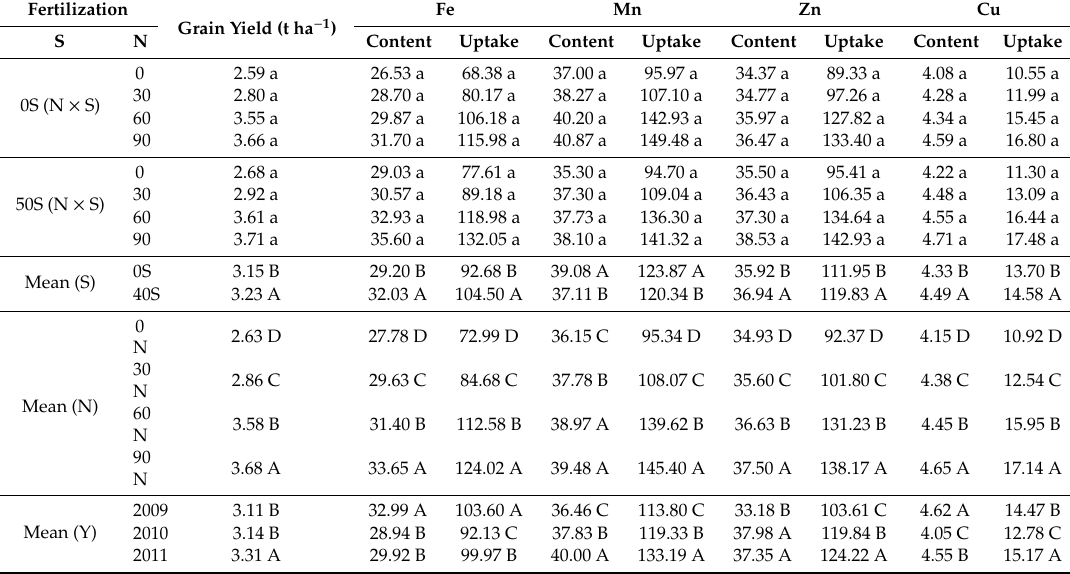
Table 6. The influence of nitrogen (N) and sulfur (S) application on the grain yield (t ha − 1 ) and content (mg kg − 1 ) and uptake (g ha − 1 ) of micronutrients by spring rye whole-grain DM. Fertilization Fe Grain Yield (t ha − 1 ) S N